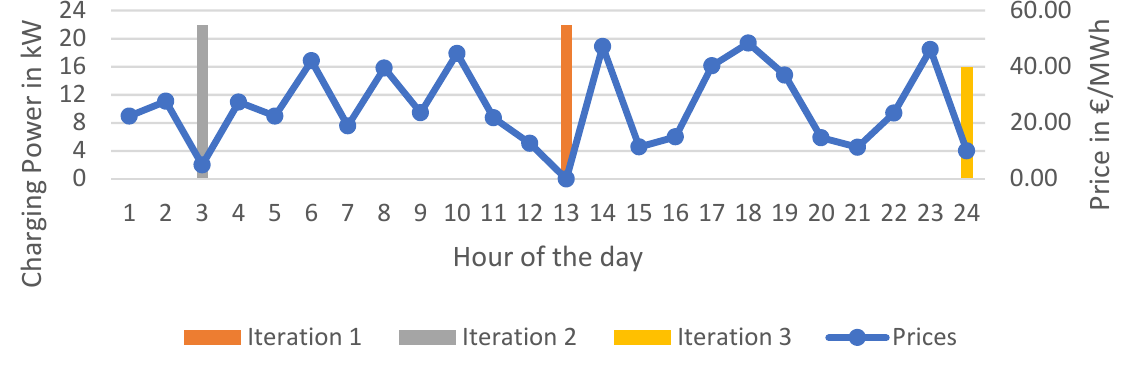
Figure 7. Example of the price-optimisation algorithm. The prices are illustrative only. Iterations 1 to 3 show the charging power that the algorithm would assign to each hour assuming that the vehicle was connected for 24 h, required 60 kWh, and was able to recharge at 22 kW. Charging was first assigned to hour 13, as the price was the lowest. The next-lowest price was at hour 3, and the algorithm decided to also charge with full power during that hour. Since 44 kWh were already charged, only 16 remained to be charged at the next-cheapest hour,